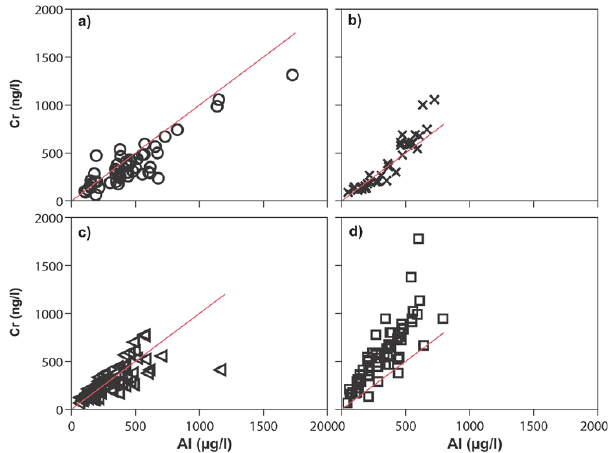
Fig. 8. Concentration of total chromium (ngL − 1 ) against total alu- minium (µgL − 1 ) at the four rivers (a) Danshytte ˚ an, (b) Getryggs ˚ an, (c) Anr˚ase ˚a and (d) Lugn˚an.